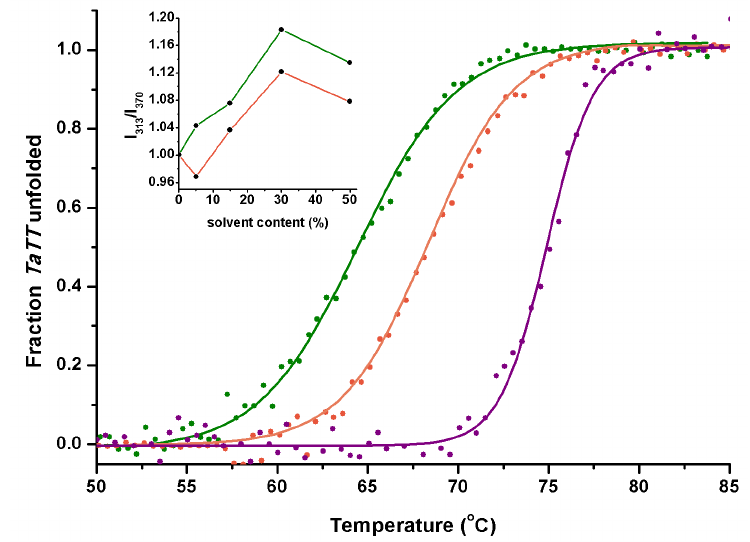
Figure 3. Thermally-induced unfolding curves of TaTT in Na-phosphate bu ff er (purple) and in the presence of 15% DMSO (orange) or 15% methanol (olive). Inset: The dependence of I 313 / I 370 for 0.1 mg / mL TaTT on percentage ( v / v ) of methanol (olive) and DMSO (orange) in Na-phosphate bu ff er at 50 ◦ C. The data are the averages from triplicate experiments.